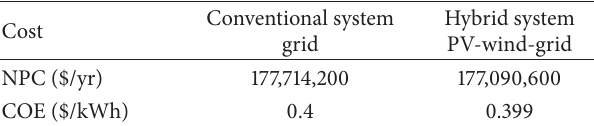
Figure 11: Structure of the production system (PV-wind-grid).